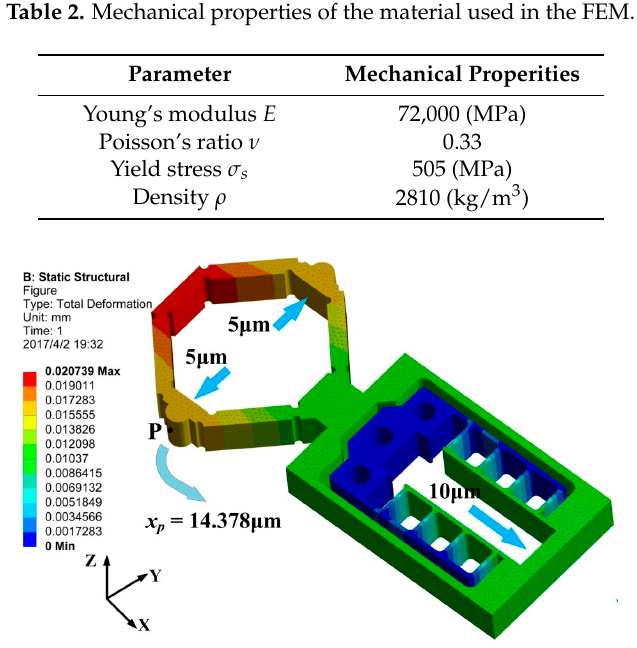
Figure 4. FEM result of the flexure hinge in the working direction.